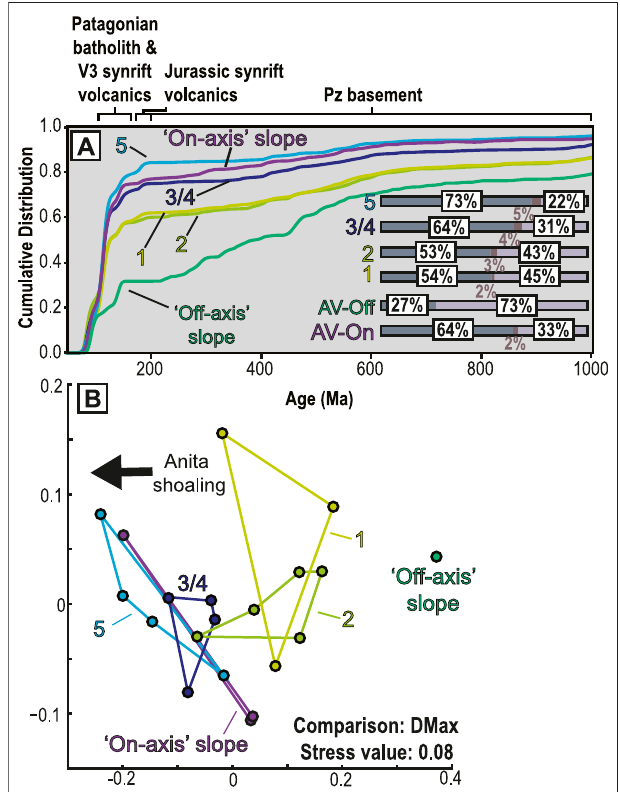
FIGURE 11 | (A) Cumulative frequency distributions of compiled detrital zircondatafromtheLaAnitaandAltaVistaFormationsaccordingtolithofacies association. Note the progressive increase in arc-derived material coincident with shoaling stratigraphy and whether or not the Alta Vista Formation grouping is representative of an “ on-axis ” or “ off-axis ” environment. (B) Multidimensional scaling plot using the DMax value of the K-S statistic of detrital zircon data from the Alta Vista and La Anita Formations grouped according to lithofacies association. Stress value = 0.08 (reasonable stress values are typically de fi ned as < 0.1; Kruskal, 1964). Note the grouping of lithofacies associations according to the interpreted similarity in depositional environments. Moreover, note that “ on-axis ” Alta Vista Formation samples group closer to LFA-5 and LFA-3/4 while the “ off-axis ” sample is closer to LFA-1 and